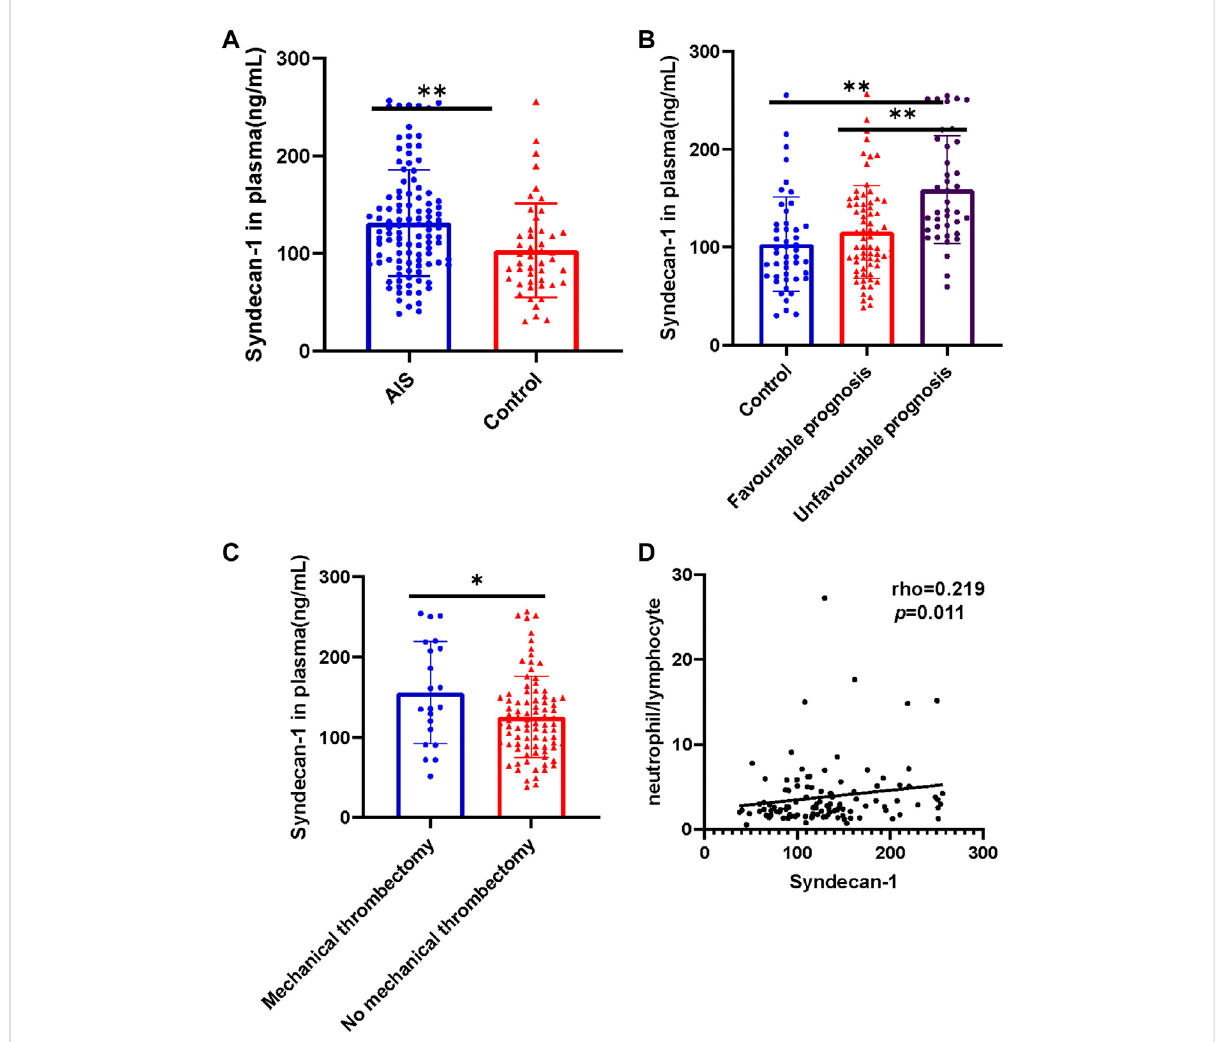
FIGURE 2 Plasma levels of syndecan-1 protein and their relationship with the neutrophil/lymphocyte ratio in different subgroups. (A) Comparison of plasma syndecan-1 levels between patients with AIS treated using intravenous thrombolysis and controls; (B) among the control group ( n = 47), favorable prognosis group ( n = 69), and unfavorable prognosis group ( n = 39); (C) between patients treated with and without mechanical thrombectomy. (D) Correlation between syndecan-1 levels and neutrophil/lymphocyte ratio. The control group included healthy participants, while the AIS group included patients treated with intravenous thrombolysis ( n = 108). * p < 0.05, ** p < 0.01. AIS, acute ischemic